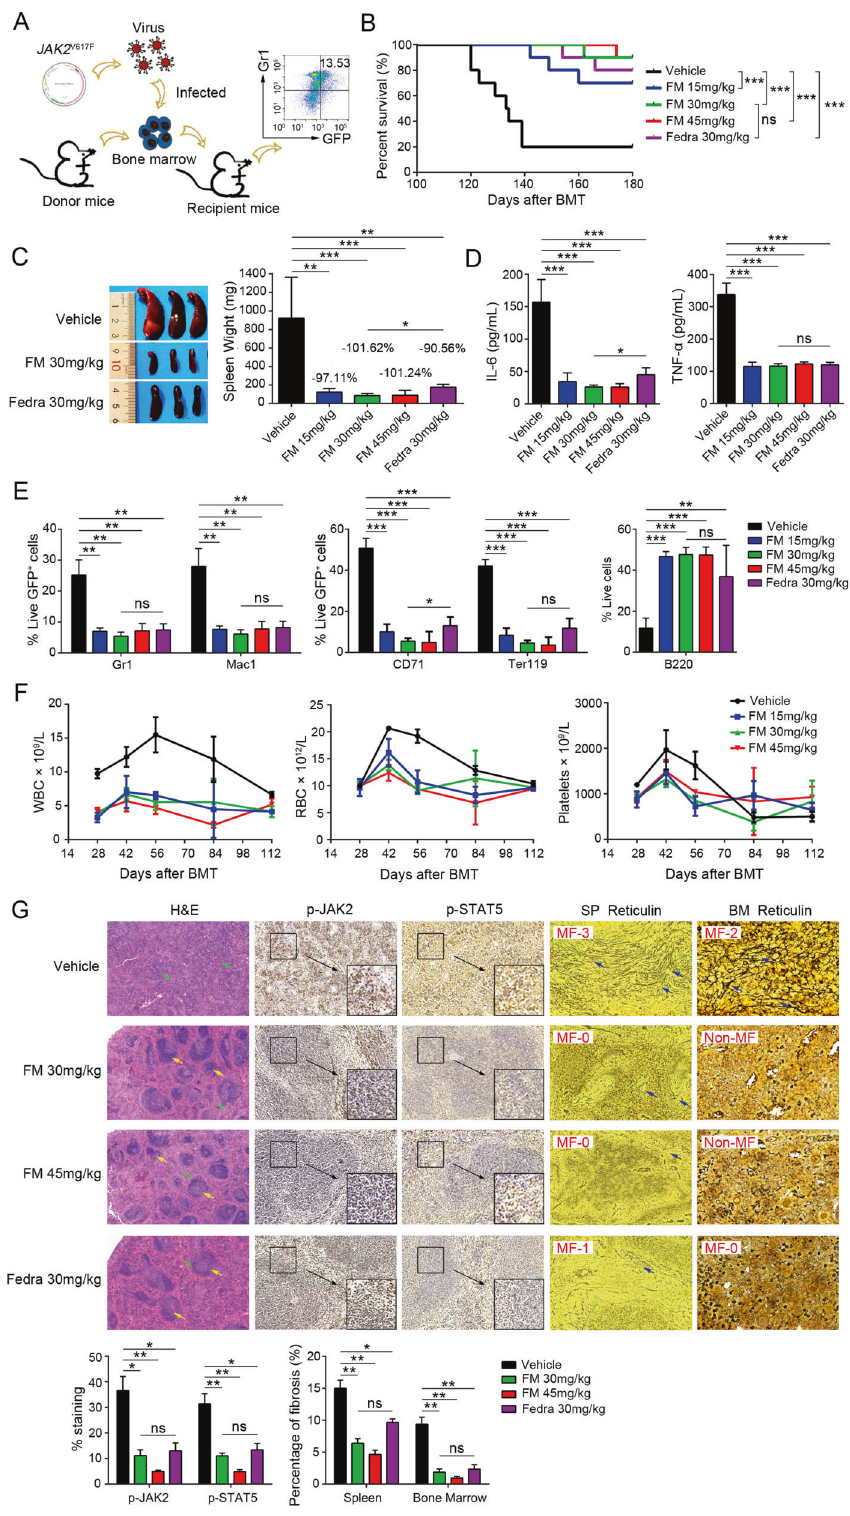
The antitumor activity of FM on JAK2 and FLT3 mutant cell lines showed that the anti-proliferative IC 50 of FM was better than that of ruxolitinib and fedratinib. The p-JAK2, p-STAT5, p-STAT3, and p-ERK protein levels were signi fi cantly downregulated by FM in both JAK2 and FLT3 mutated cell lines. Moreover, FM could signi fi cantly